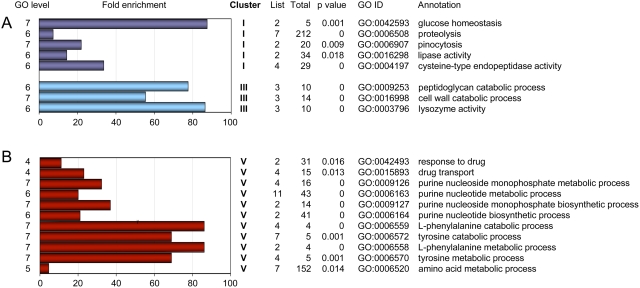
Functional annotation of coregulated, CbfA-dependent genes.Genes from clusters I–VI, as defined in Figure 5, were separately subjected to GO term enrichment analyses. Significant enrichment of GO biological process and protein activity terms was only detected for clusters I, III, and V as indicated. The bars indicate fold enrichment. The table indicates the number of genes in a particular annotation (List), on the entire array (Total), the significance for enrichment (p value), the corresponding GO ID number, and the annotation.